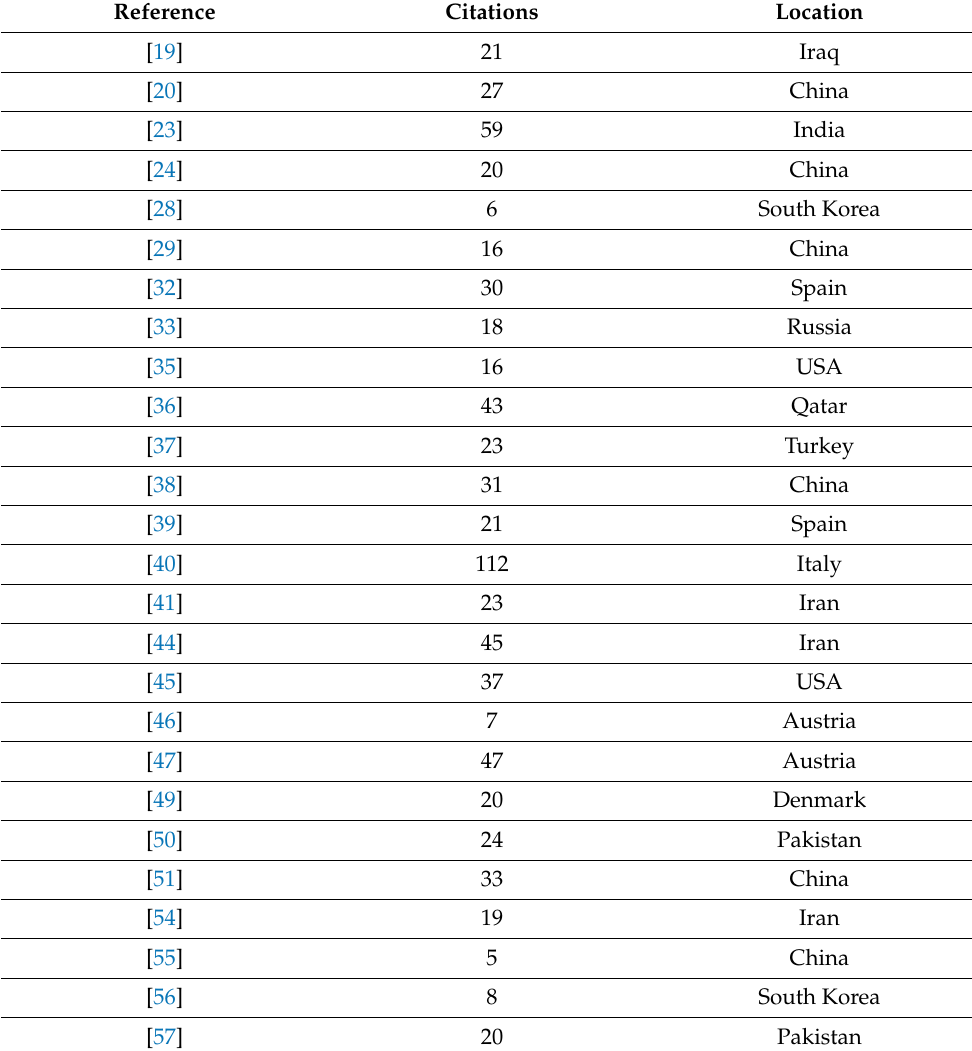
Table A2. Number of citations and location of selected articles with at least 5